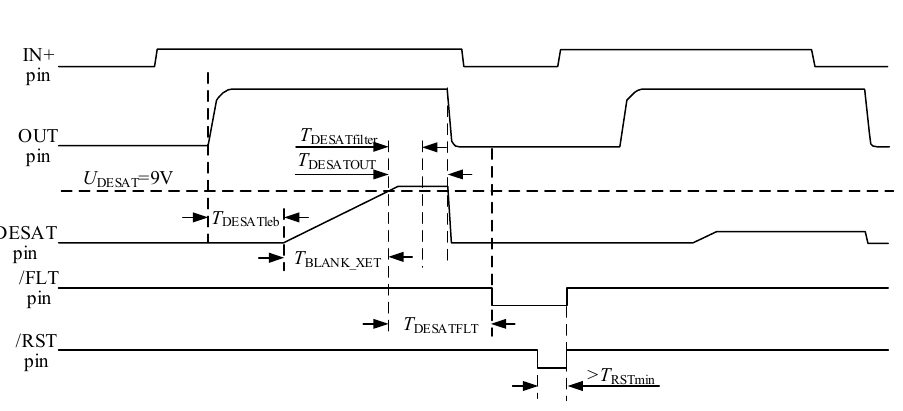
Figure 7. The time sequence of the desaturation detection.